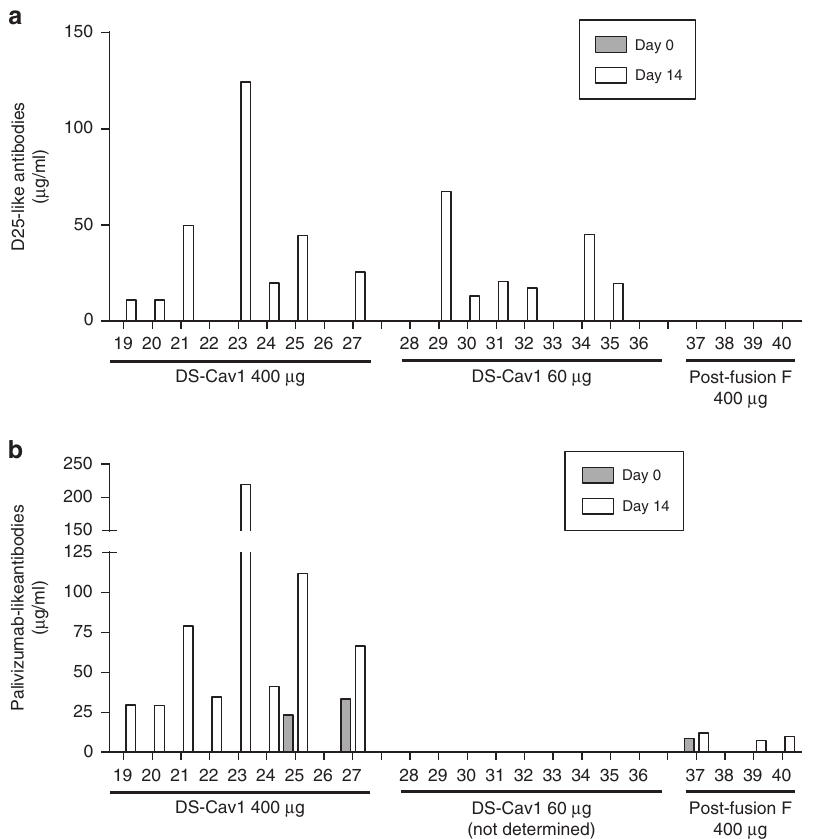
Fig. 5 Antibody competition assays. Serial dilutions of Day 0 and Day 14 individual serum samples were pre-incubated with biotinylated D25 ( a ) or Palivizumab ( b ). D25- or Palivizumab-competing antibodies in the sample prevent binding of the biotinylated antibodies to the DS-Cav1 coated-plate, allowing the quanti fi cation of D25-like or Palivizumab-like antibodies. a D25-like antibodies: no D25-like antibodies were detected in any of the animals on Day 0. Asterisks indicate animals where D25-like antibodies were below the limit of detection either on Day 0 or Day 14. b Palivizumab-like antibodies: samples from the DS-Cav1 60 µ g group were not tested. In the DS-Cav1 and Post-fusion F groups, absence of grey histograms indicates samples with palivizumab-like antibody levels below the limit of detection on Day